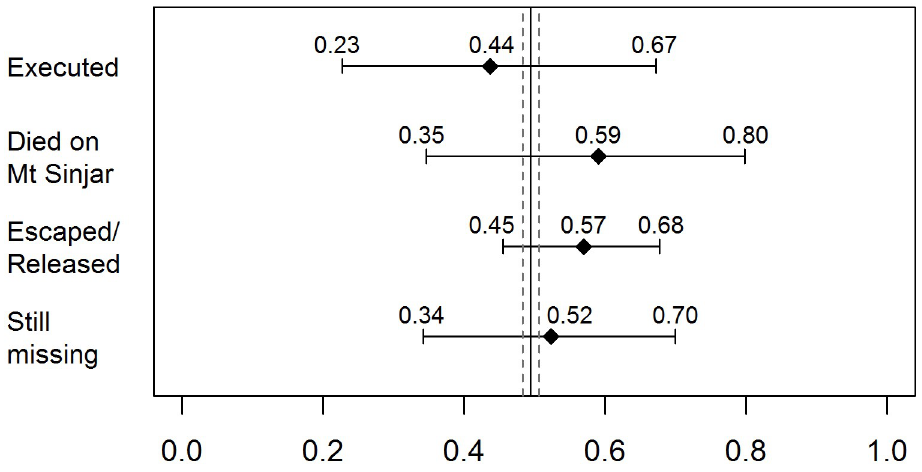
Fig 5. Estimated proportion of females (all ages) among all killings and kidnappings with 95% CIs. Note: The vertical line is the estimated proportionof females (all ages) in the Yazidi populationwith 95%